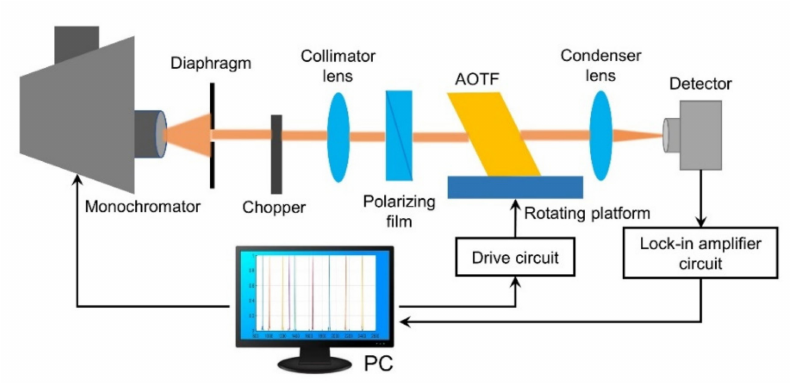
Figure 3. The AOTF testing